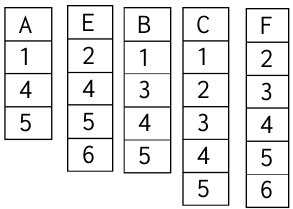
Figure 2. TID lists for modified database in Table 5.